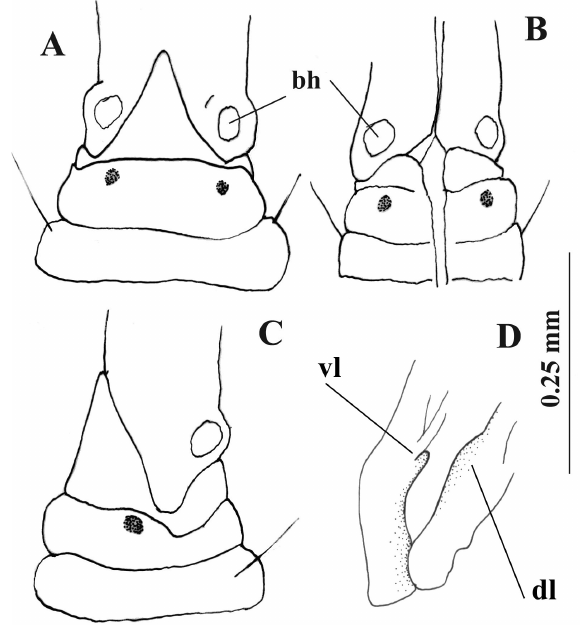
F IG . 3. – Novafabricia posidoniae n. sp. Anterior peristomial ring: A, ventral view from a paratype; B, dorsal view from same paratype; C, lateral view from same paratype; D, right-half of branchial crown, inner margin. bh= branchial heart; vl= ventral lip; dl= dorsal